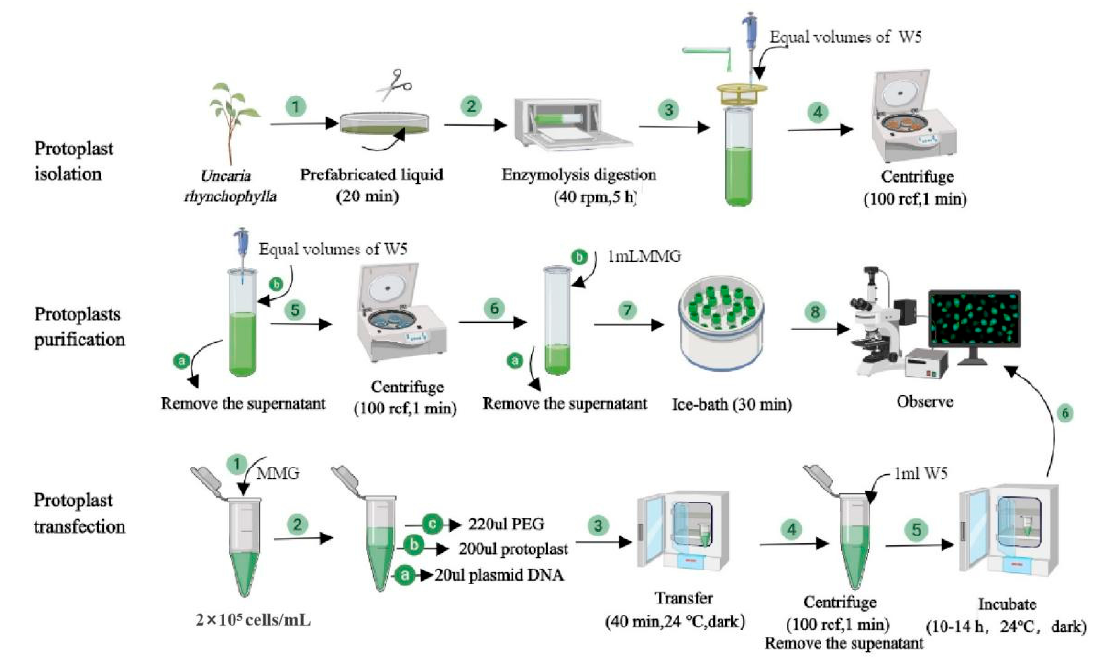
Figure 5. Schematic diagram of extraction, purification, and transformation process of U. rhyn- chophylla